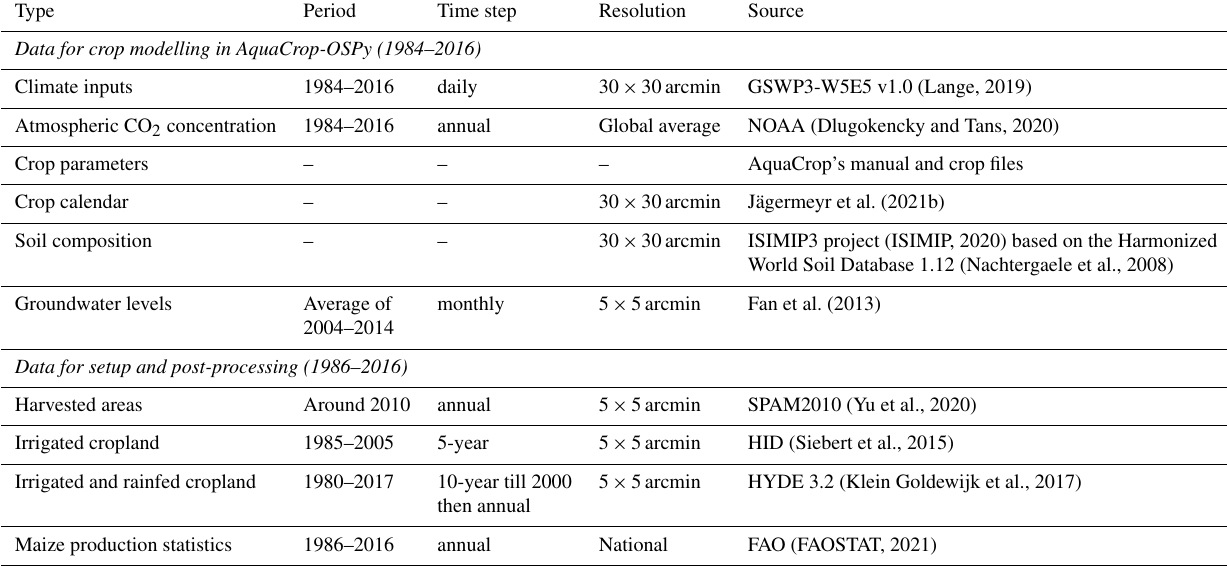
Table 1. Summary of input data used for maize crop modelling and post-processing in